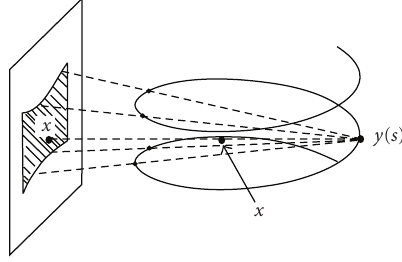
Figure 5: The family of lines L ( s 2 ). The filtering is performed along lines L ( s 2 ).